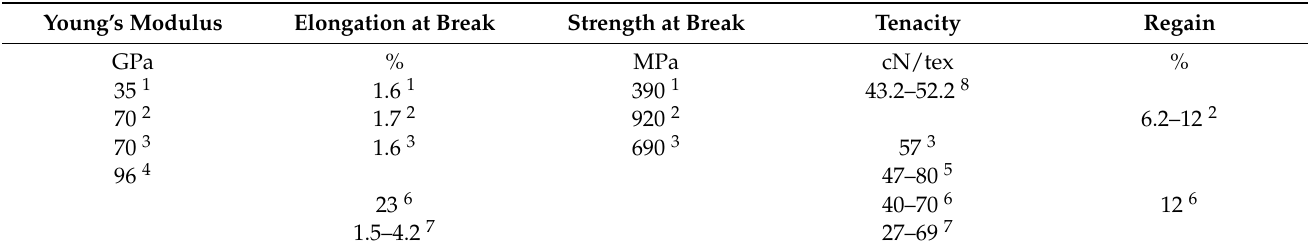
Table 4. Values of mechanical properties of hemp fibres based on data provided by different